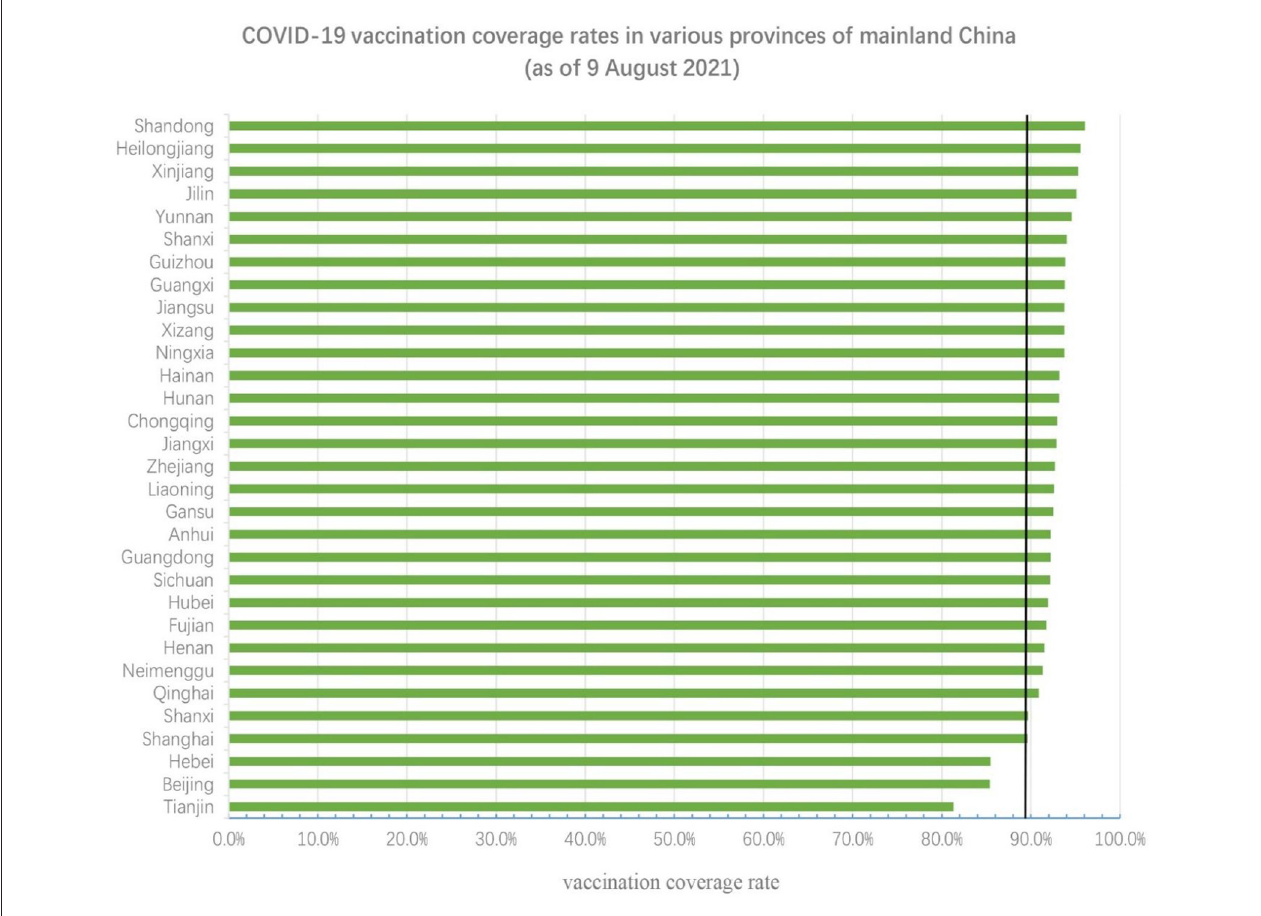
FIGURE 2 | COVID-19 vaccination rates in different provinces. The black vertical line represents the national average level